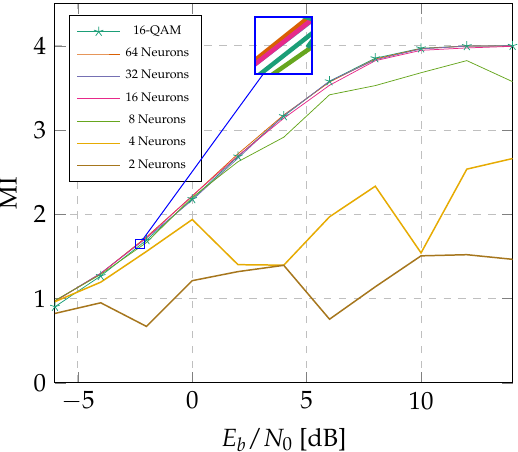
Figure 3. ANN topology optimization for different number of neurons compared to 16-QAM.